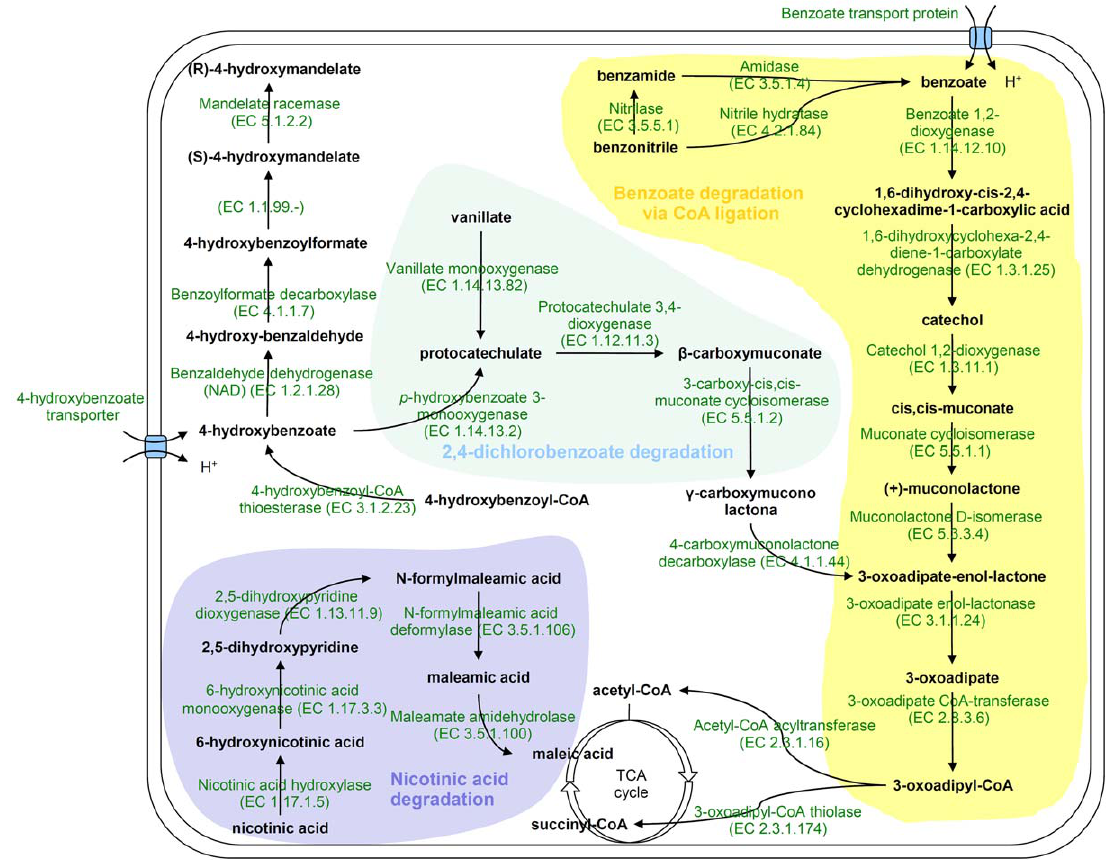
Figure 3. Proposed pathways for aromatic compounds metabolism in H.seropedicae SmR1.